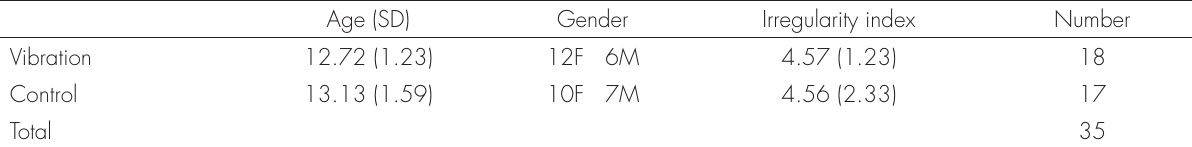
Table I. Baseline demographics of subjects completing the